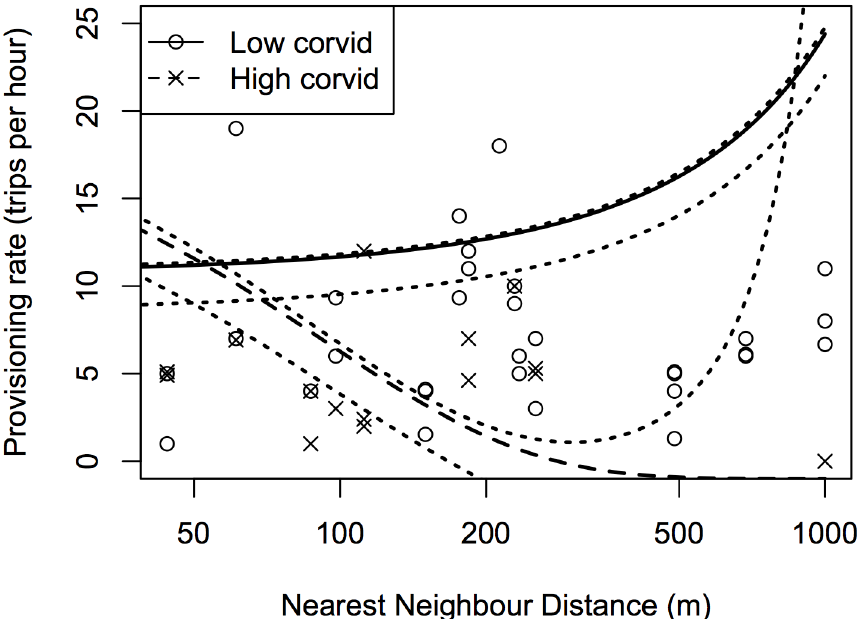
Fig 1. Nestling provisioning rate was influenced by an interaction between NND and corvid abundance. Points show raw data with corvid abundance split into above and below median values (corvid abundance is categorized in the graph for ease of visualization but designated as a continuous variable in the model). Lines are predicted from the final averaged model (Table 7) with median values of other factors causing additional variation in the final model (nestling age = 5 days, brood size = 3 nestlings, temperature = 15°C, year = 2008, farm management = conventional), at the two extremes of observed corvid activity levels along with the median value (low = 0; high = 59; median = 3 corvids passing within 100m of the nest in a 20 minute period prior to assessment of yellowhammer provisioning rate). 95% confidence intervals are shown for all three predictions. For 5 points where provisioning rate was constant for the same nest on more than one occasion, we have added a slight ‘ jitter ’ ( ± 0.1 provisioning trip) for display purposes only to allow sample sizes to be